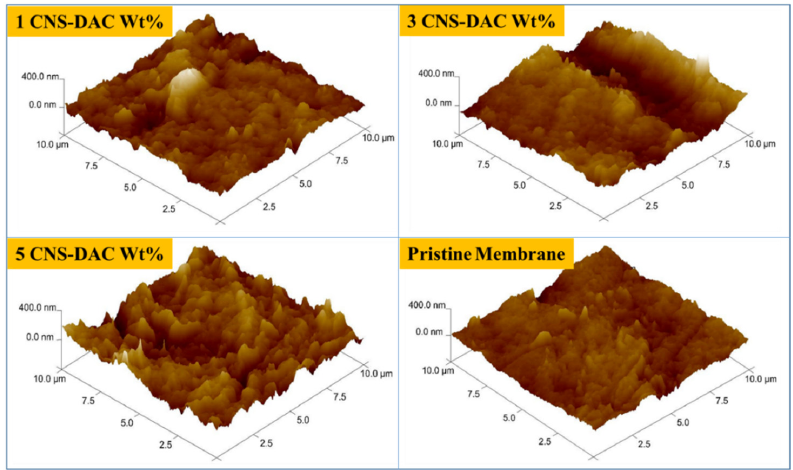
Water 2022 , 14 , x FOR PEER REVIEW Figure 7. 3D AFM images of the membrane prepared from different CNS loadings. Figure 7. 3D AFM images of the membrane prepared from different CNS loadings.